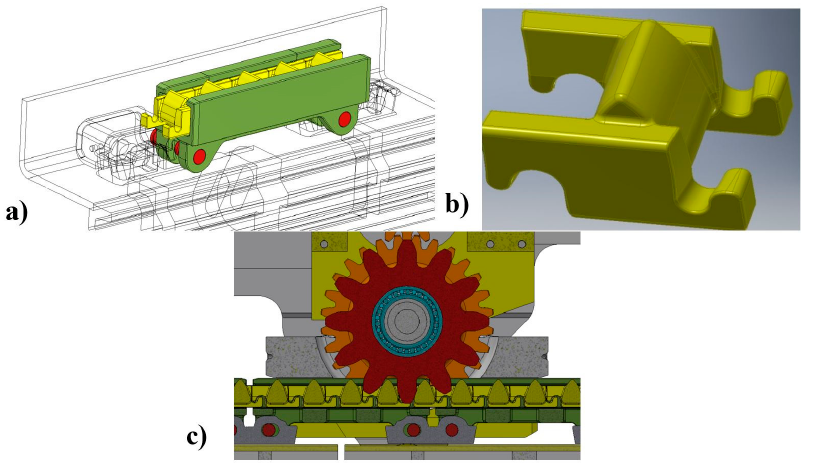
Figure 8. Komtrack haulage system: ( a ) 3D model of the guide and toothed segments installed on the conveyor line pan, ( b ) 3D model of a new version of the Komtrack toothed segments, ( c ) model of collaboration between the shearer drive wheel with toothed segments.